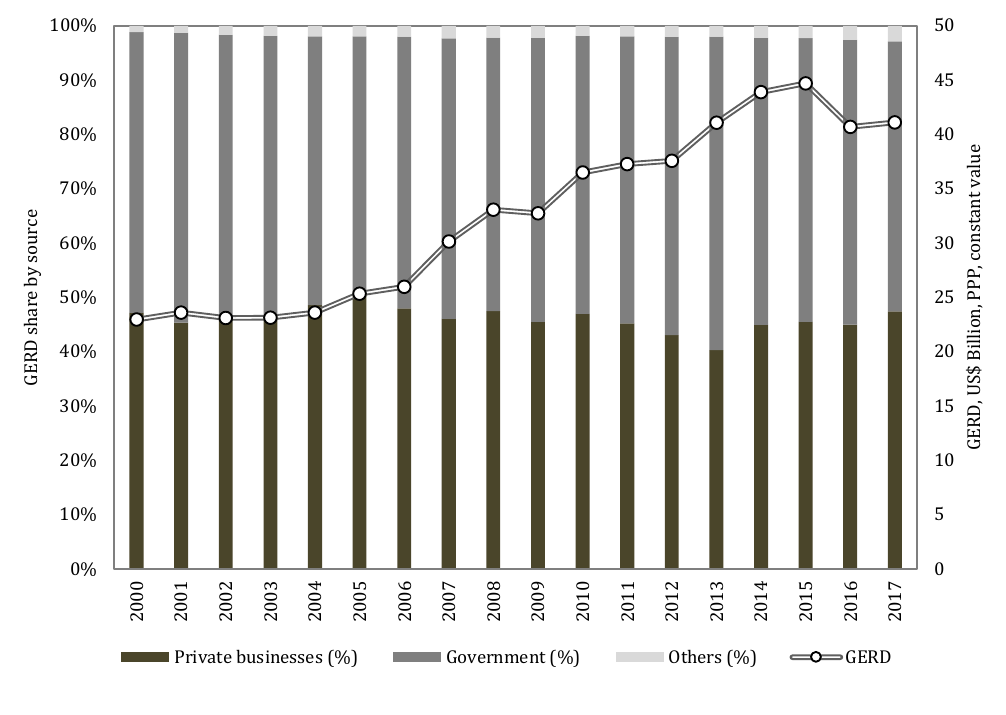
Figure 05 . GERD and its share by funding source, Brazil, 2000 –